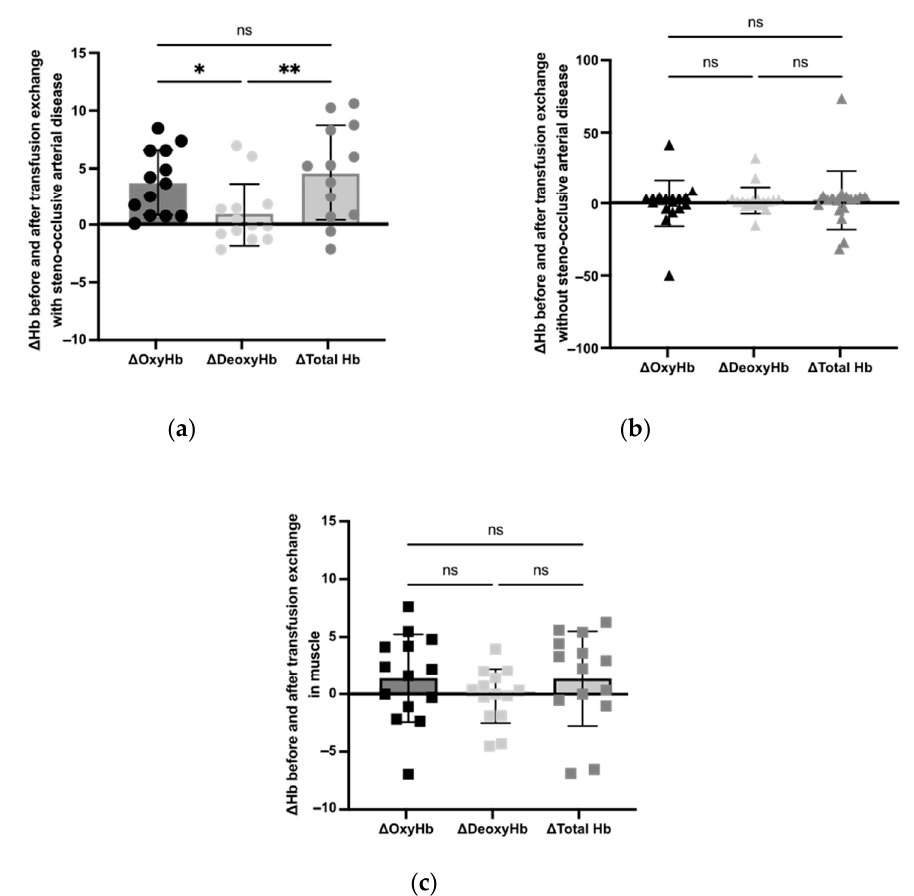
Figure 2. Measurement of ∆ OxyHb, ∆ DeoxyHb, and ∆ Total Hb before and after BET. Shaded boxes show values obtained. ( a ) ∆ OxyHb, ∆ DeoxyHb, and ∆ Total Hb in cerebral hemispheres with steno-occlusive arterial disease ( n = 13). *, p < 0.05; **, p < 0.01 using the Friedman test. ( b ) ∆ OxyHb, ∆ DeoxyHb, and ∆ Total Hb in cerebral hemispheres without steno-occlusive arterial disease ( n = 18). ns using the Friedman test. ( c ) ∆ OxyHb, ∆ DeoxyHb, and ∆ Total Hb in muscle ( n = 14). ns using the Friedman test.